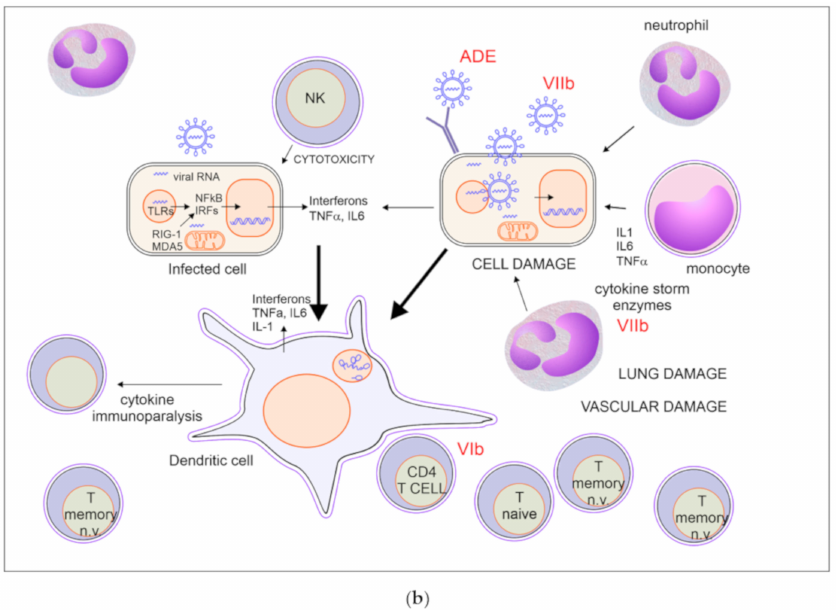
Figure 1. ( a ) Immune response to SARS-CoV-2 with e ff ective recovery. For explanation, see